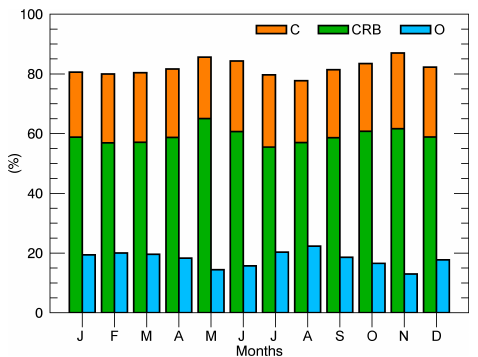
Figure 9. Monthly percentage moisture contributions to the CRB from continental sources (orange bars), the CRB itself (green bars), and oceanic sources (blue bars). The data are from FLEXPART for the period